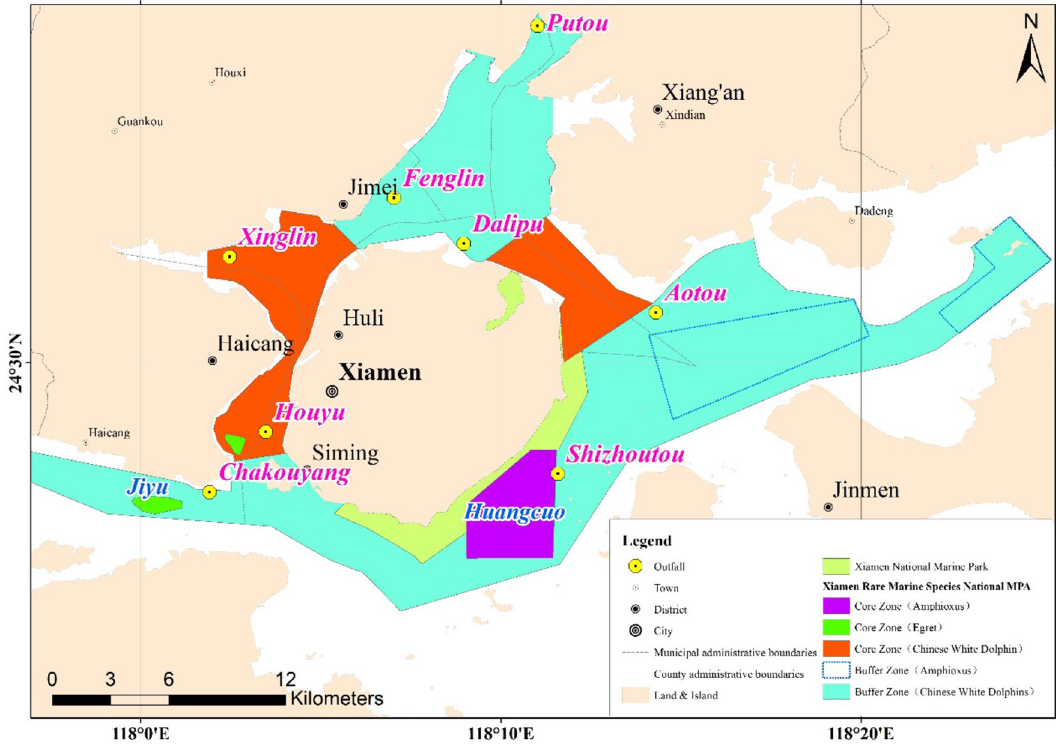
Figure 2. Location of pollutant discharge sea areas in Xiamen and marine eco-environment sensitive areas of XMB. The figure was drawn with ArcGIS software version 10.0 (https:// www. arcgis. com/ index. html).